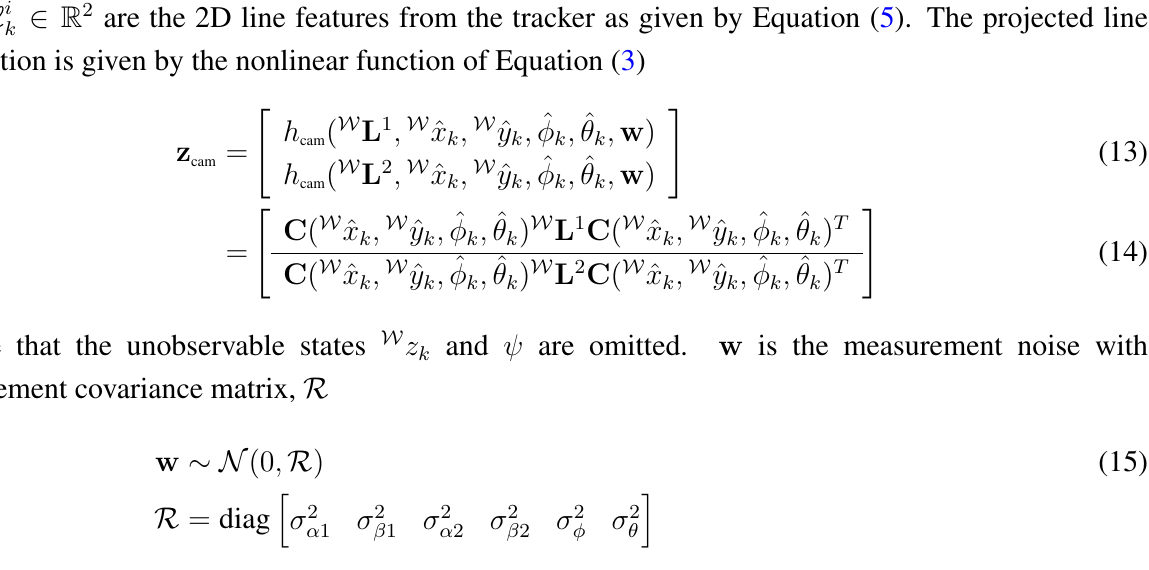
R 2 denoting their corresponding projection onto a , b , c , d k k k k ∈